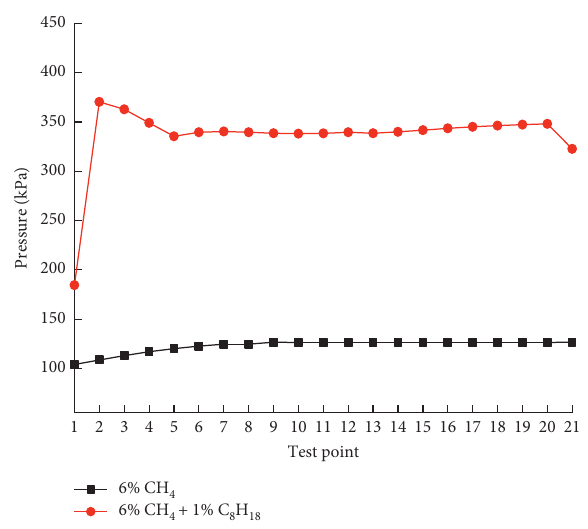
4 . (b) 6% CH 4 +1% C 8 H 18 .